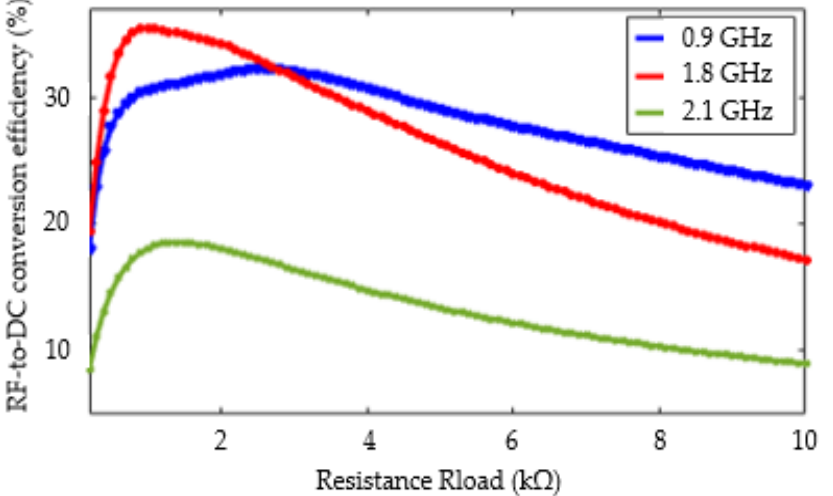
Figure 12. RF-to-DC efficiency simulation as function of the resistance load for an input power set to 0 dBm.